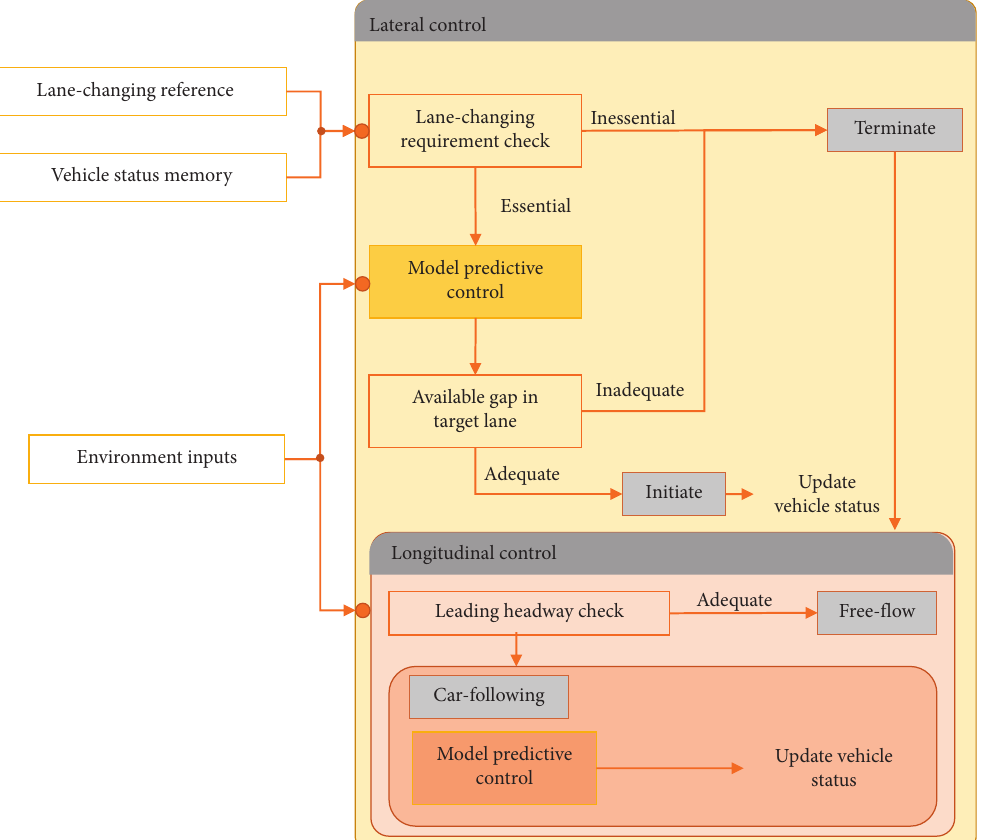
Figure 1: Control decision process of an individual vehicle at each timestep.